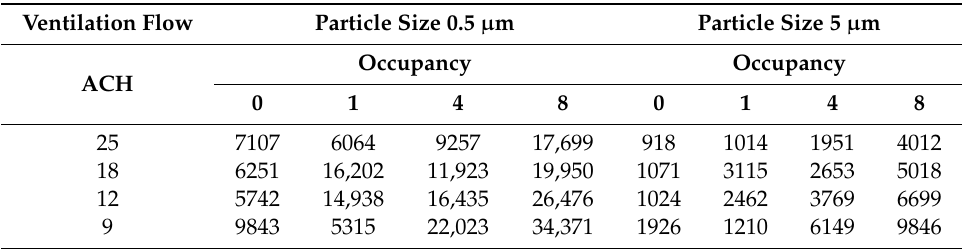
Figure 5. Particle measured values (0.5 µ m). Table 6. Mean measured values during the